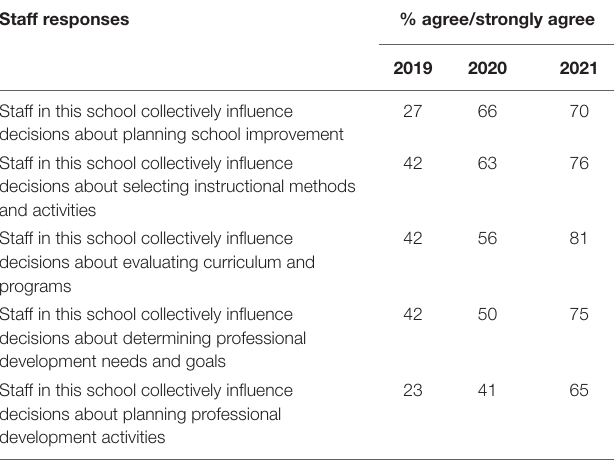
TABLE 2 | School staff survey – teacher collaboration in school